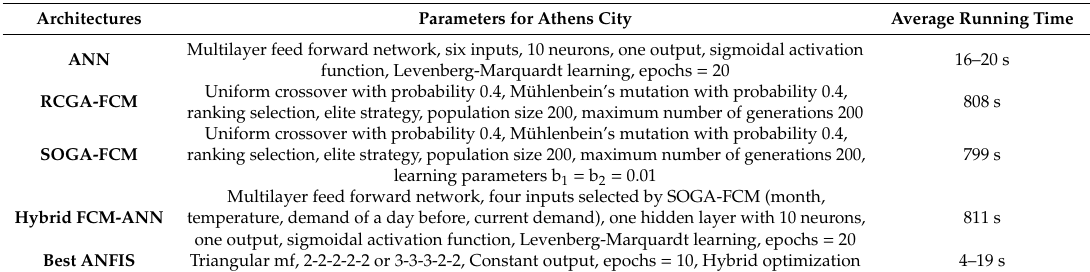
Table 8. Parameters and average running time for each